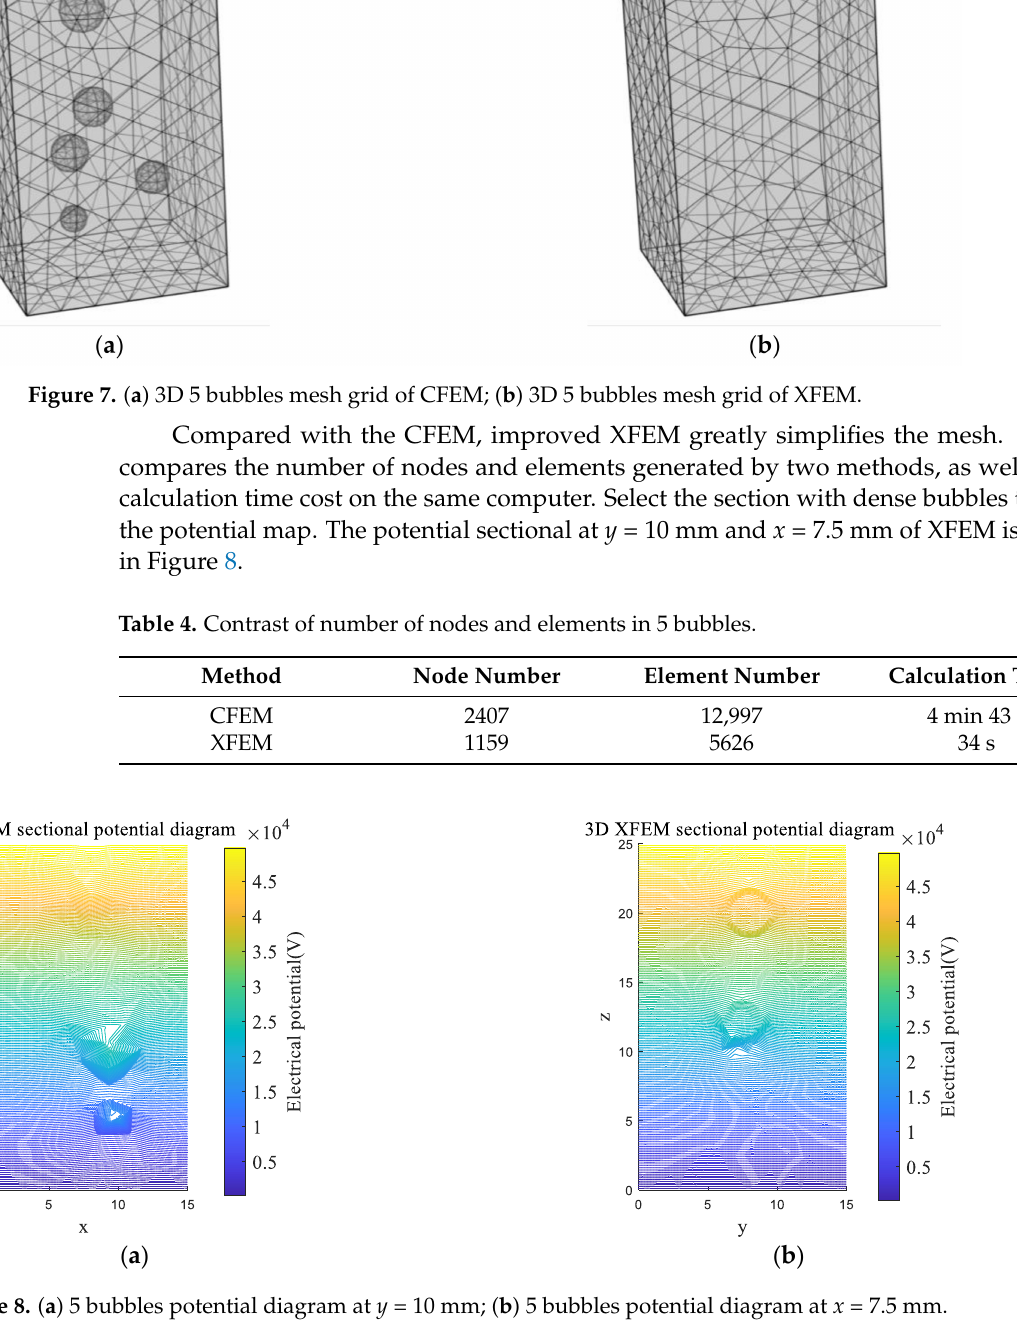
Table 5. Contrast of the results of nodes near interface.